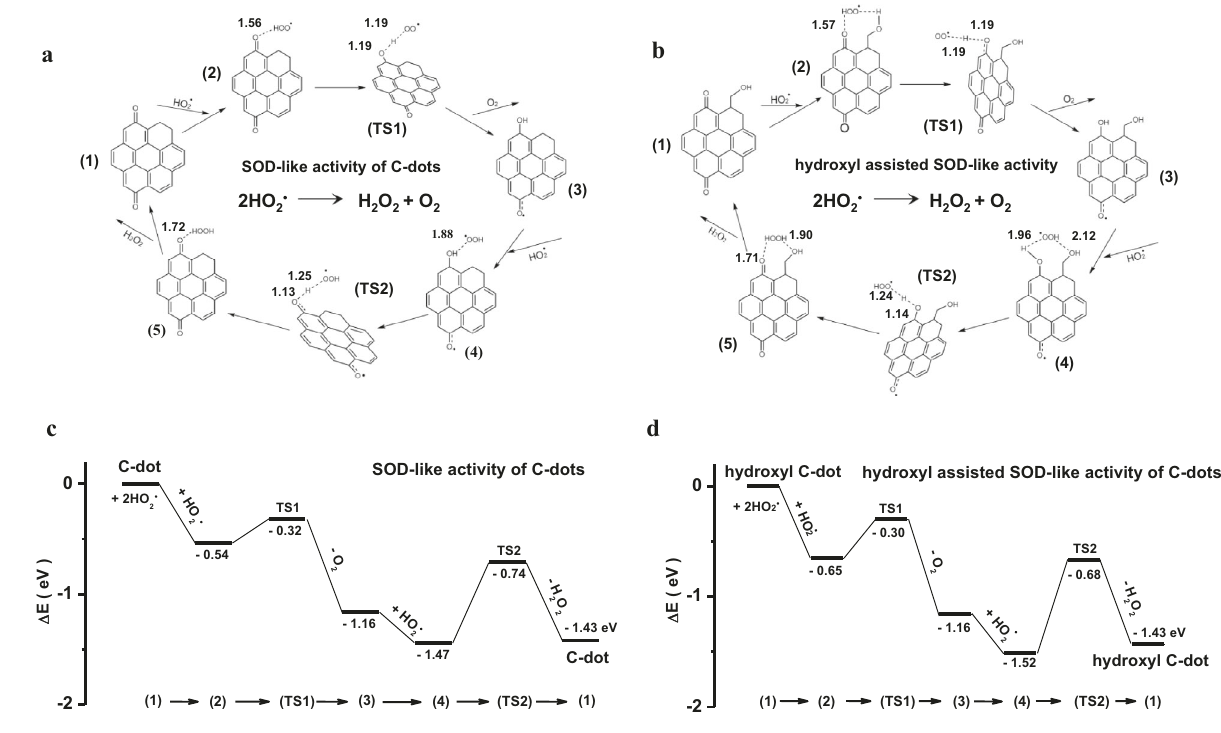
Fig. 4 | Proposed SOD-like activity of C-dot nanozyme with and without hydroxyl groups. a Proposed reaction pathway to achieve the SOD-like catalytic cycleofC-dotnanozymewithouthydroxylgroups. b Proposedreactionpathwayto achieve the SOD-like catalytic cycle of C-dot nanozyme with hydroxyl groups.